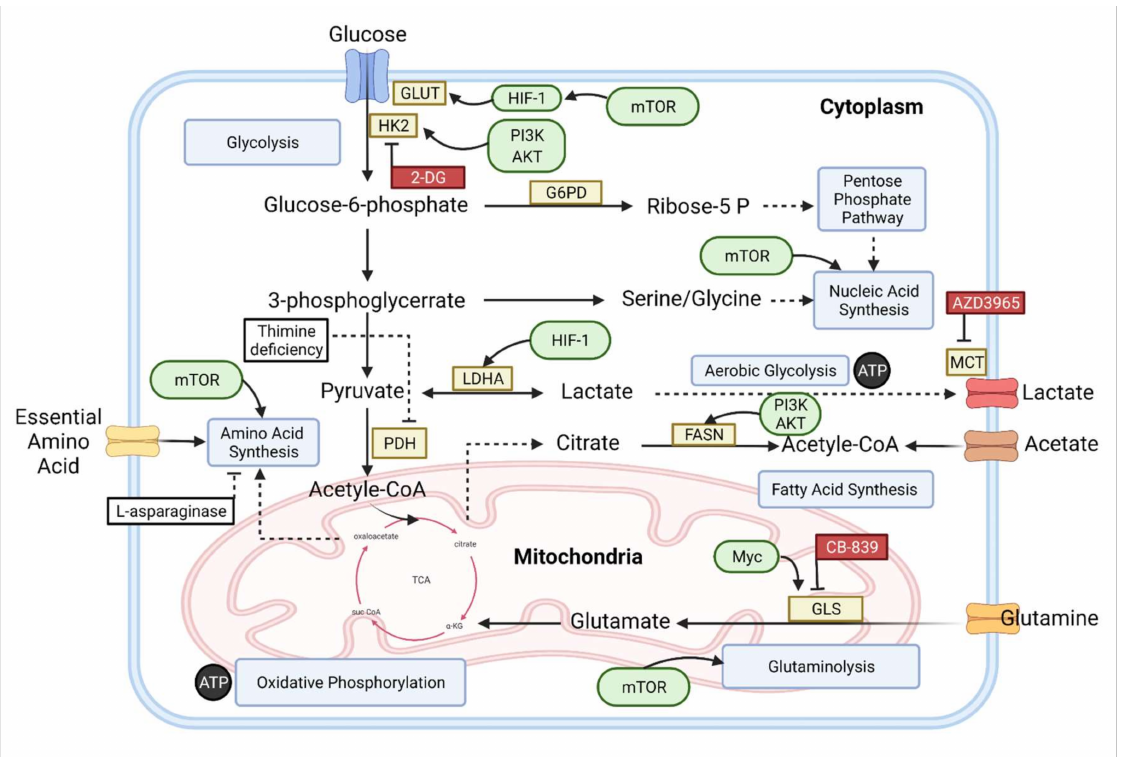
Figure 1. Metabolic pathways associated with B-cell lymphoma [12–17]. Biomarkers are useful in confirming malignant or benign diseases with asymptomatic subjects in the early stages of cancer and in patients examined for neoplastic